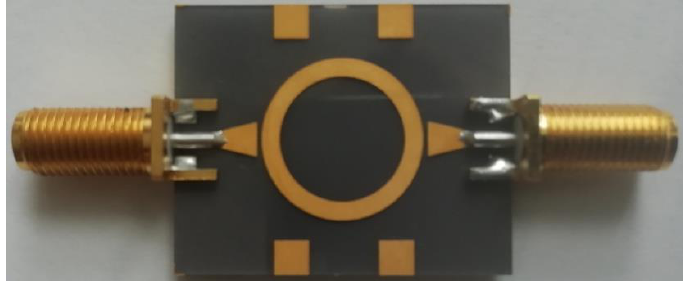
Fig. 1. The structure of microstrip ring resonator.